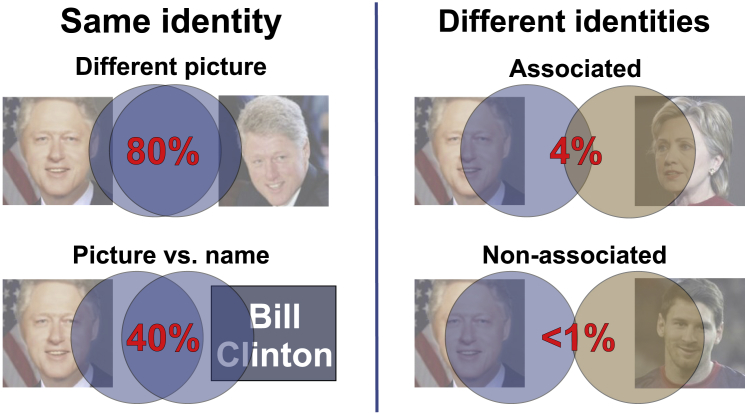
Schematic Summarizing Some of the ResultsWhen a picture from Bill Clinton is shown, a cell assembly of MTL neurons will fire in response to the stimulus. When another picture from Bill Clinton is presented, the set of MTL neurons firing has a large overlap (∼80%) with the previous assembly. When the written name is presented, the overlap of activated neurons is much lower (∼40%), as the very different sensory information carried by the name leads to very distinct cortical inputs to the MTL. In turn, the results from [28] showed that when the picture of Hillary Clinton is presented, a highly associated concept to Bill Clinton, a small overlap of ∼4% will be activated by both stimuli. Still, this small proportion is much larger than the < 1% observed for non-associated pictures (e.g., Bill Clinton and Lionel Messi), providing a substrate for encoding a meaningful association.